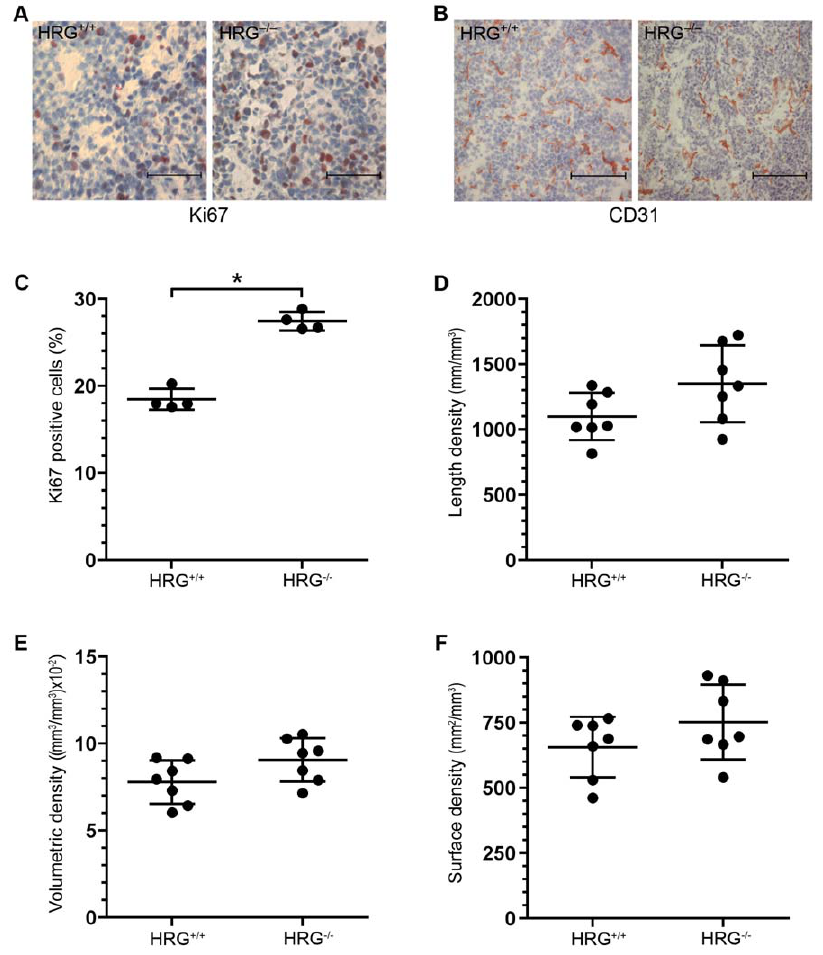
Figure 3. Proliferation and vascularization in tumors from RT2/HRG + / + and RT2/HRG 2 / 2 mice. (A, B) Immunohistochemical staining of tumor tissue from HRG + / + and HRG 2 / 2 mice directed against Ki67 (A) and CD31 (B). (C) Quantification of immunohistochemical staining directed against Ki67 was performed on tumor sections from RT2/HRG + / + and RT2/HRG 2 / 2 mice. Data are presented as percentage of Ki67 positive cells of total cell numbers. Each dot represents the value from an individual animal (n=4 for each group). (D–F) Stereological quantification of vascular parameters: length, volumetric and surface densities. Each dot represents the mean value from one individual animal (n=7 for each group). Statistical analyses were performed with a two-tailed Mann-Whitney test, vertical bars represent standard deviation, * p # 0.05. Scale bars represent 50 m m in A and 100 m m in B.